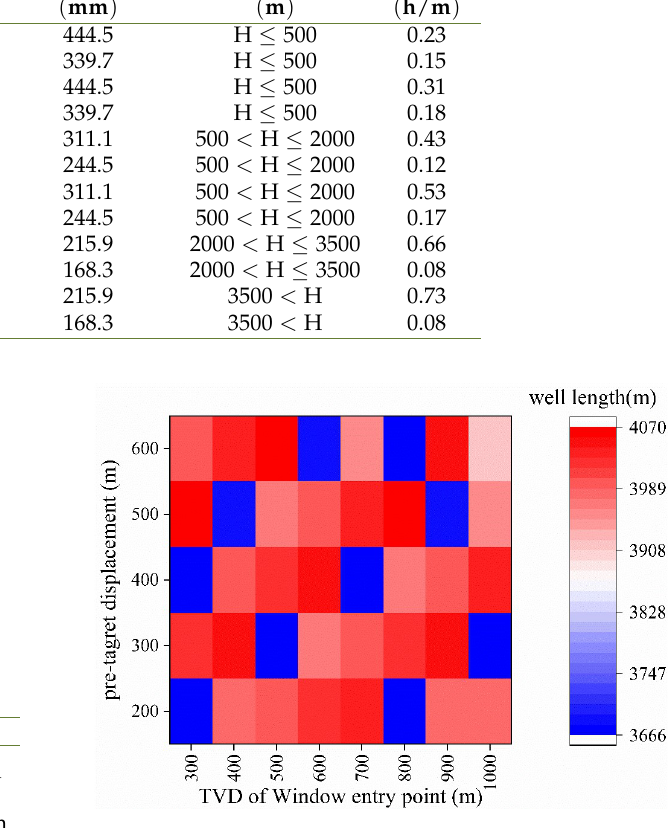
Fig. 8. The cloud map of well length with 40 different design schemes Table 5. Well path design parameters based on the